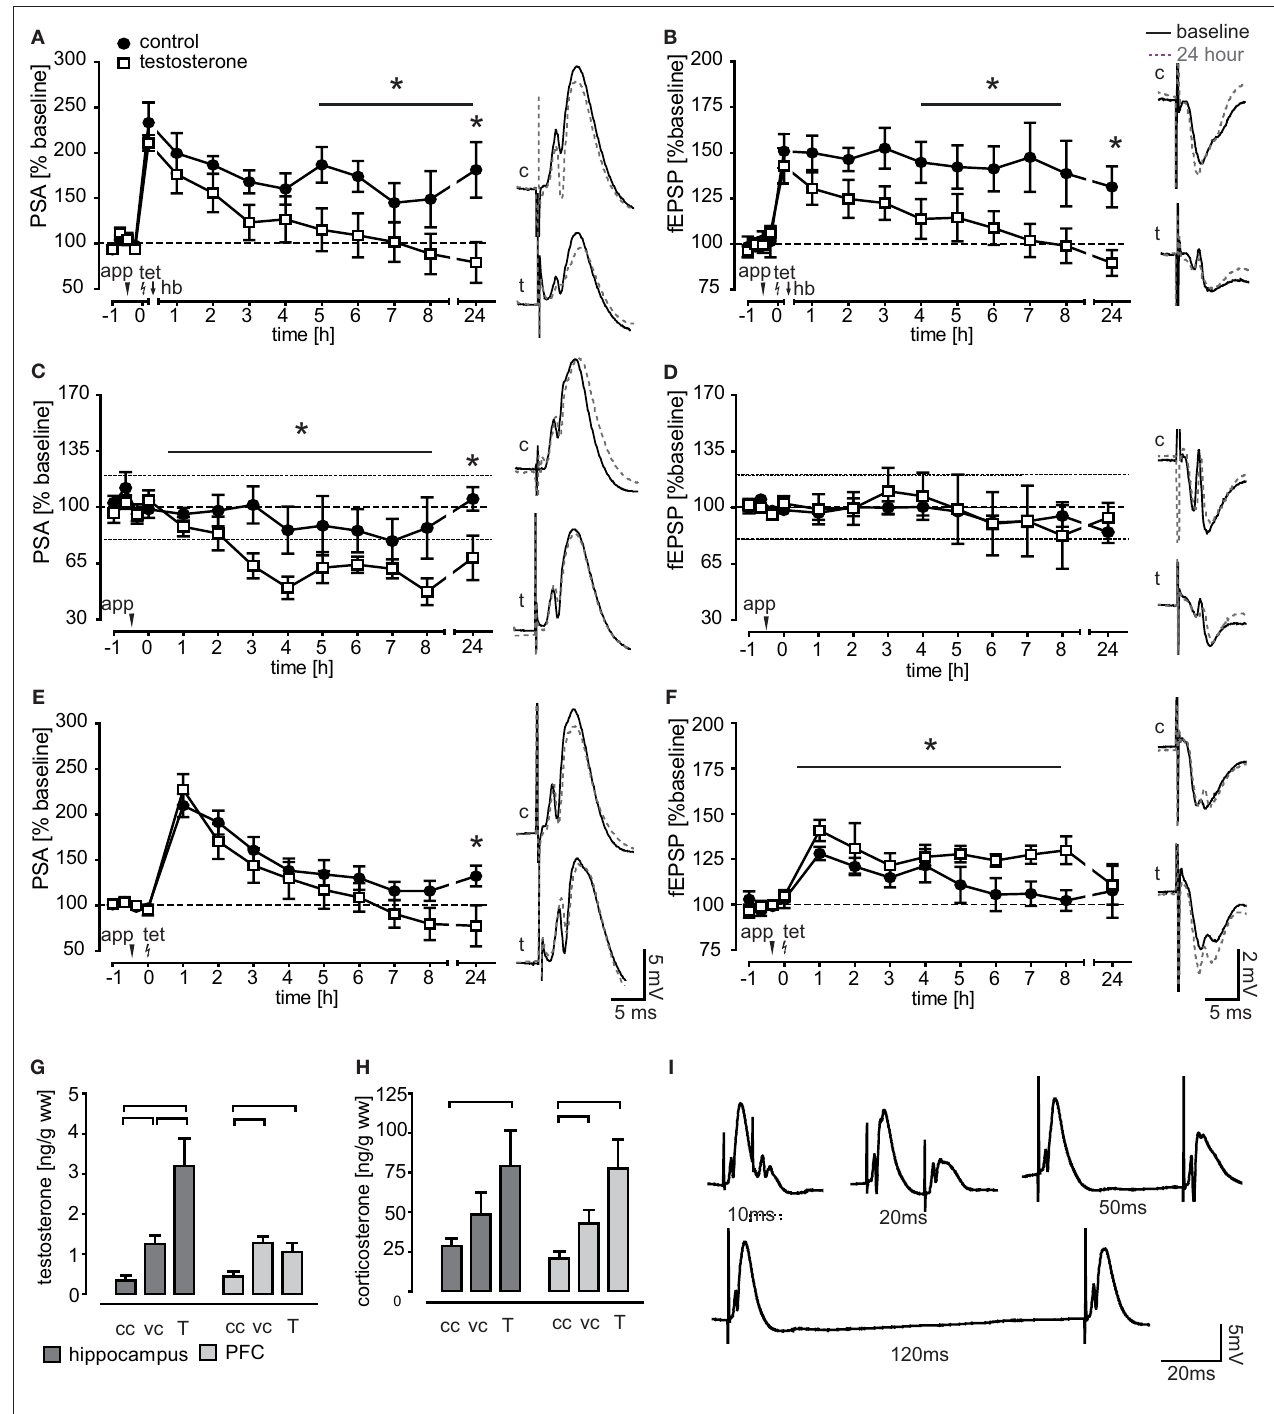
transmission while leaving the fEPSP intact. (e,F) PSA values of testosterone treated, untrained animals undergoing an LTP induction protocol were reduced at 24 h after induction, while fEPSP potentiation was prolonged for 8 h. (g,H) Brain tissue testosterone and corticosterone levels of chamber controls (cc, n = 16), vehicle applied (vc, n = 9), and animals receiving 1 μg testosterone (T, n = 9). (i) Example traces of PSA recordings in the paired pulse